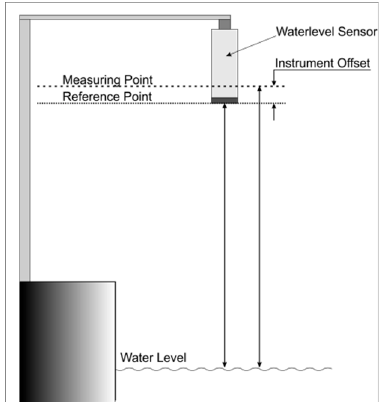
Figure 16. The zero-reference measuring point of a radar tide gauge.